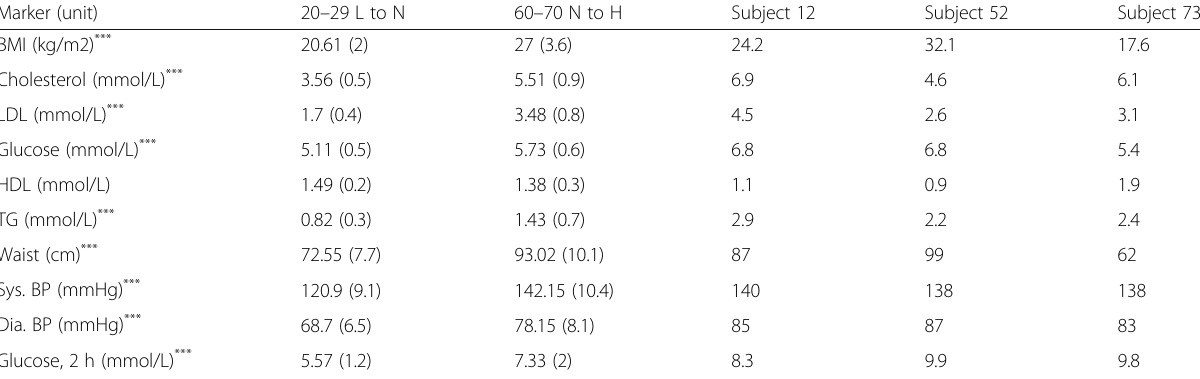
Table 3 This table shows the mean (SD) values for the two reference groups “ optimal phenotypic flexibility ” (20 – 29 L to N) and “ reduced phenotypic flexibility ” (60 – 70 N to H) as well as the values of the three outlier subjects (subjects 12, 52, and 73)